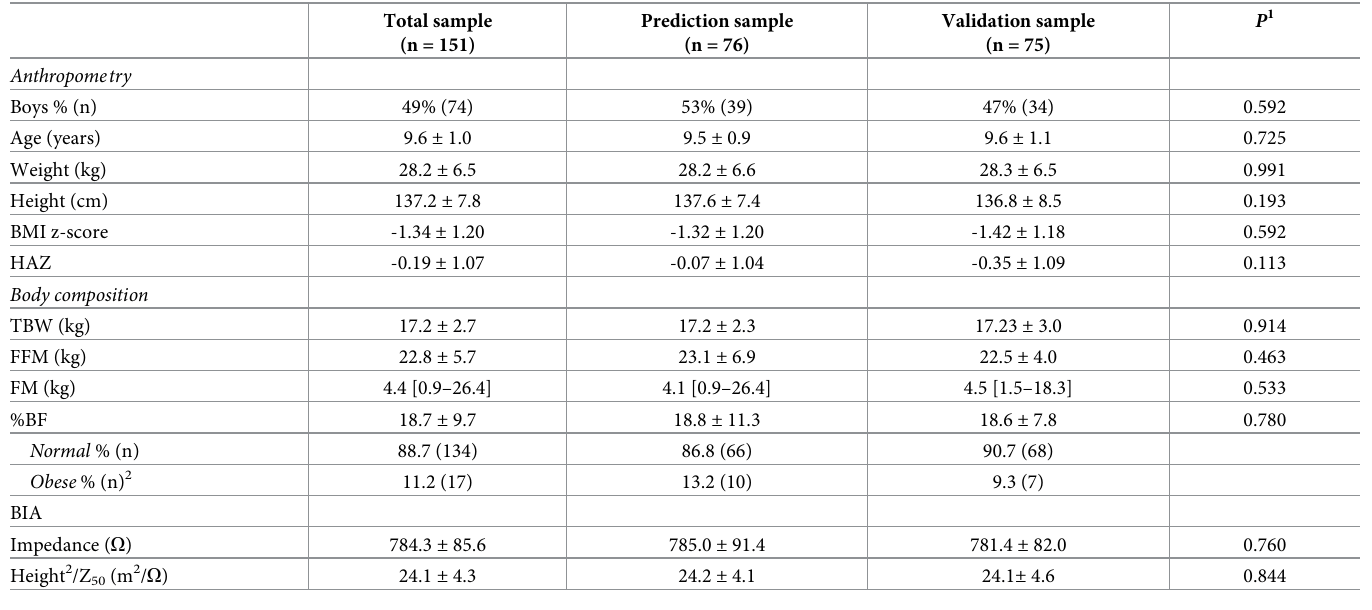
Table 1. Baseline characteristics of the children in the prediction and cross-validation